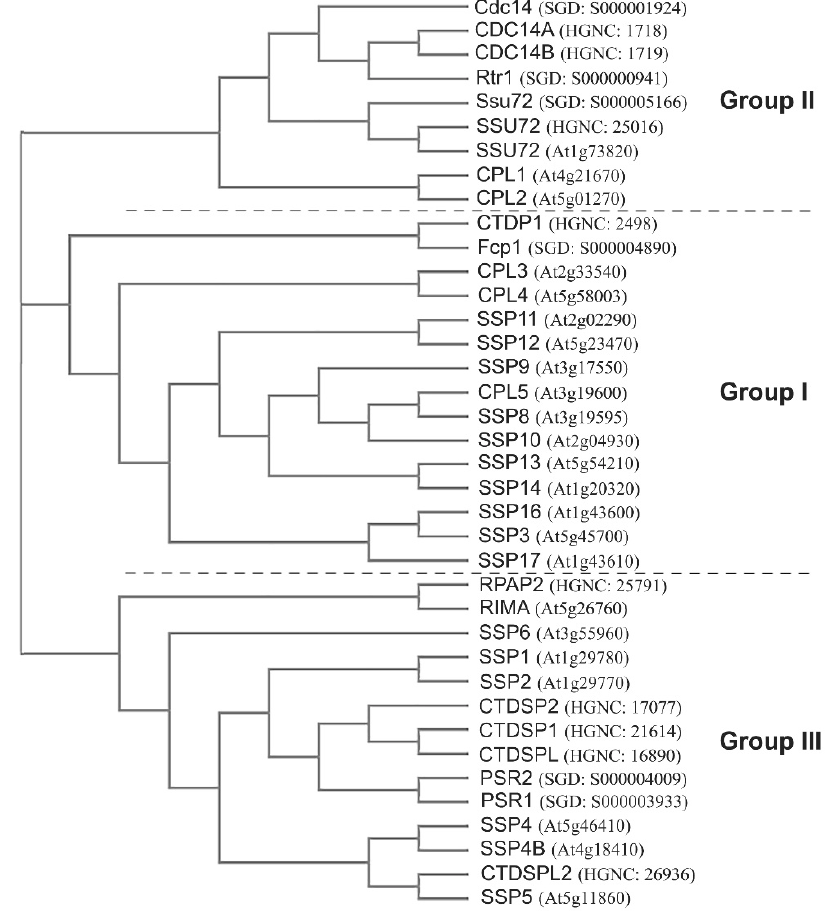
Figure 3. CTD phosphatase protein tree analysis. Full-length protein sequences of CTD phosphatases from yeast, Arabidopsis, and humans were used in the tree analysis. CTD phosphatases are separated into three groups (I, II and III). The gene ID for each protein was given in parenthesis for yeast (SGD), Arabidopsis (At), and humans (HGNC).